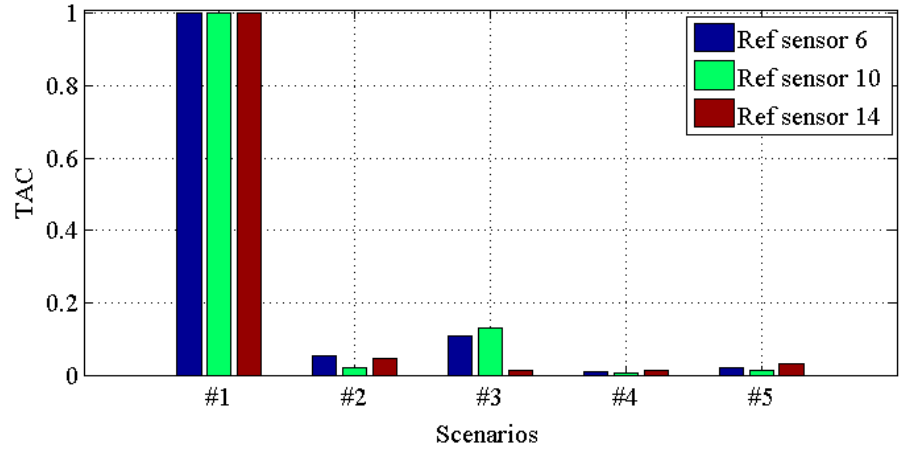
Figure 15. TAC for transmissibilities T(2, :), T(6, :), T(10, :) and T(14, :) with reference sensor 6, 10 and 14 for damage scenario #1 to #5.